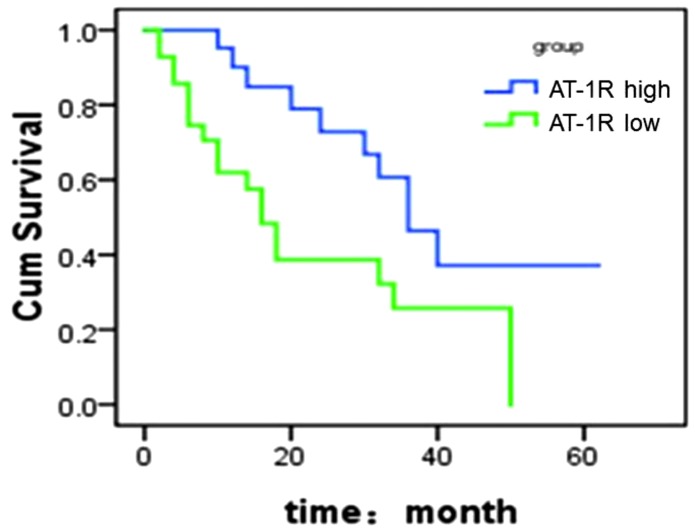
Comparison of overall survival rate of patients with high and low expression of angiotensin II type 1 receptor (AT-1R) mRNA in hepatocellular carcinoma specimens. Cum, cumulative.